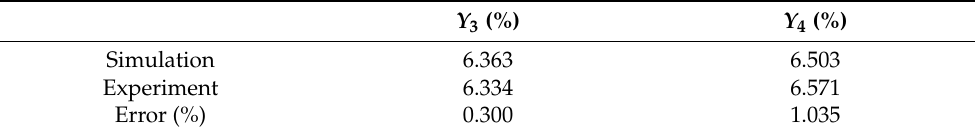
Table 5. Comparison of key dimension shrinkage rates obtained by simulation and experiment.